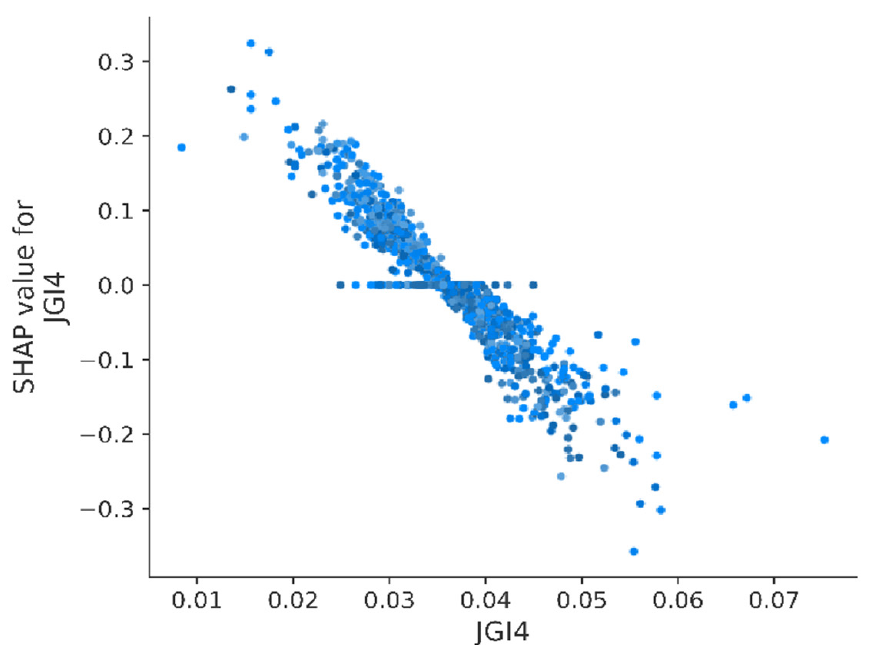
Figure 13. Calculated SHAP values for individual records as a function of JGI4 descriptor value.